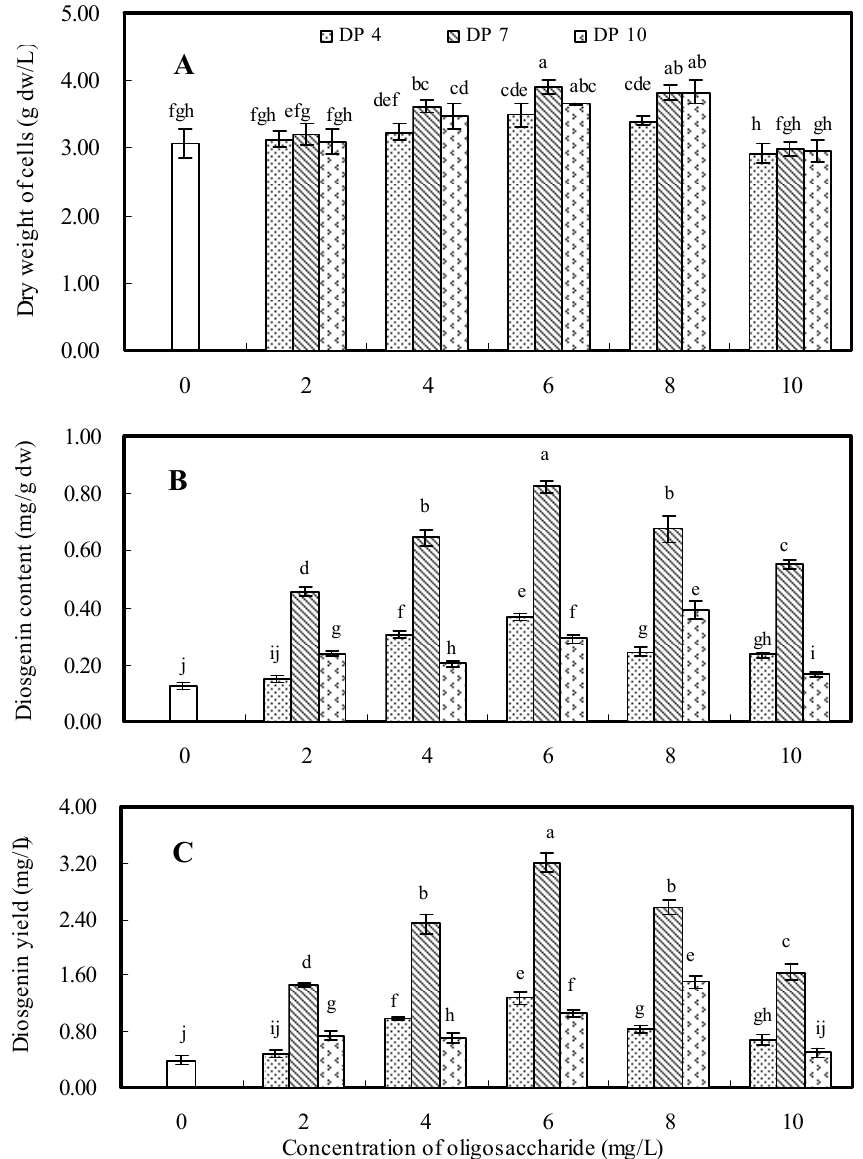
Figure 2. Effects of oligosaccharides DP4, DP7 and DP10 on dry weight ( A ), diosgenin content ( B ) and diosgenin yield ( C ) of D. zingiberensis cell cultures. The error bars represent standard deviations ( n = 3). Different letters indicate significant differences among the treatments at p = 0.05